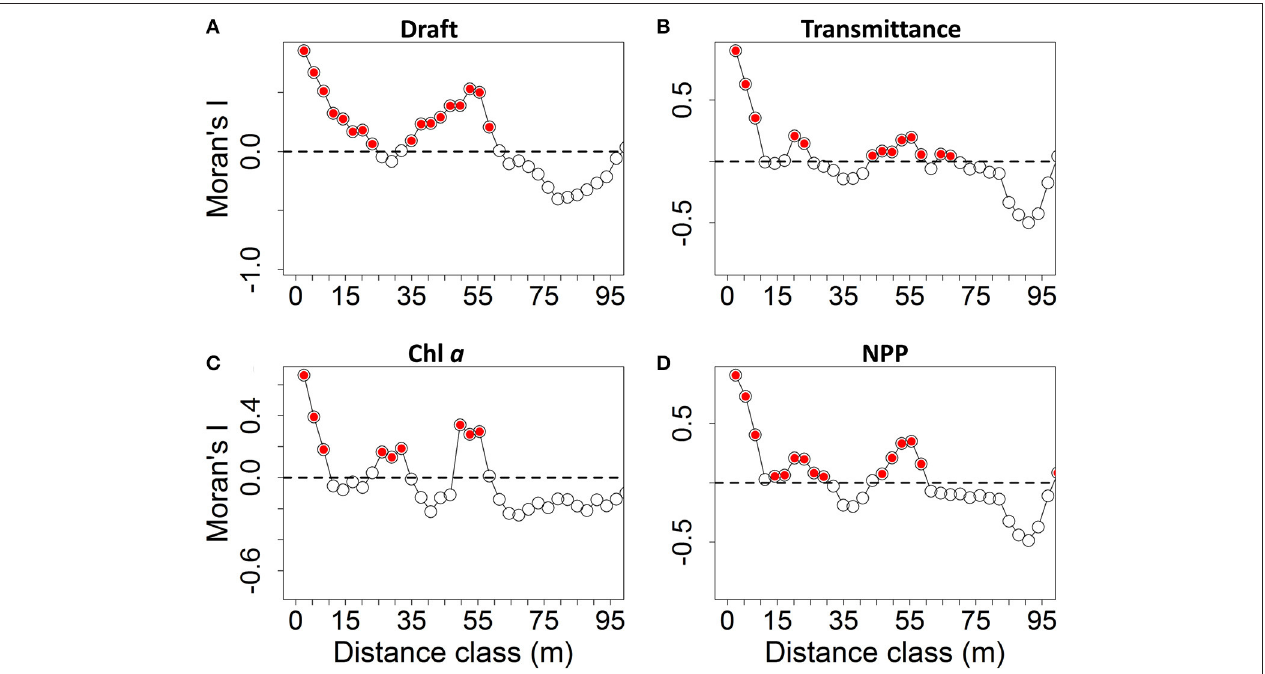
FIGURE 8 | Correlograms showing Moran’s I vs. distance classes at ROV station 224 for: (A) draft (m); (B) transmittance; (C) chlorophyll a biomass (mg m − 2 ) derived from ROV spectral radiation measurements; and (D) net primary production-NPP (mg C m − 2 s − 1 ) derived from ROV measurements. Red filled circles represent significant values at p <